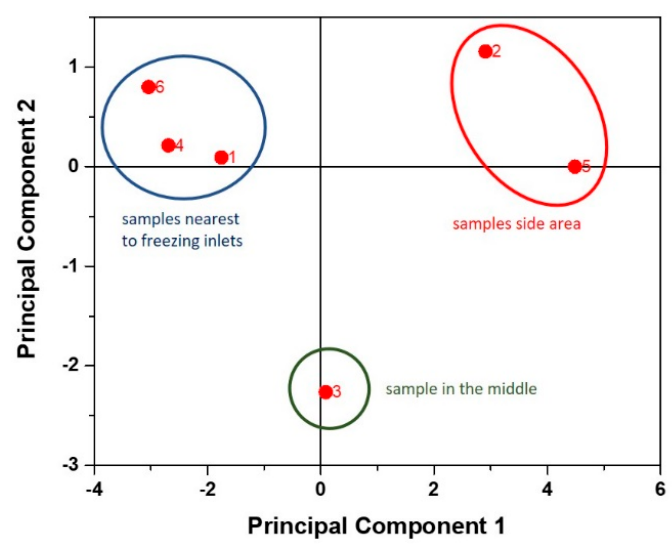
Figure 5. Principal component analysis (PCA) of data sets for titer measurement, conductivity, and monoclonal antibodies (mAB) aggregation. Principle component 2 is mainly driven by titer and mAB aggregation data of run #4 exhibiting the highest ice formation rate (IFR) rate for the lab-scale experiment.